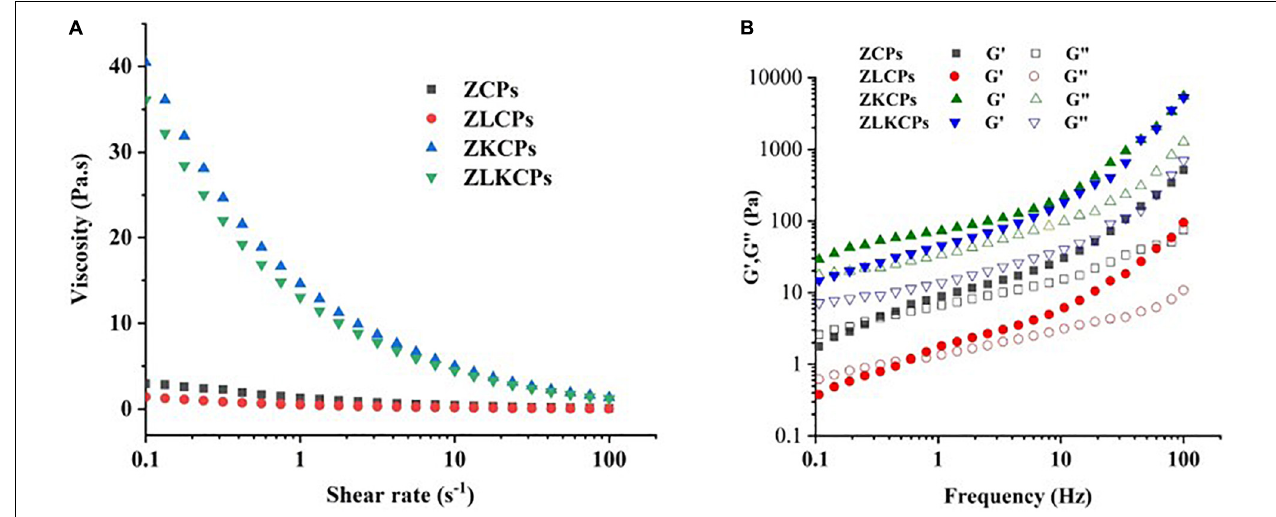
FIGURE 9 | Rheological properties of Pickering emulsion stabilized by different colloidal particles [ (A) viscosity; (B) Storage modulus (G (cid:48) ) and loss modulus (G (cid:48)